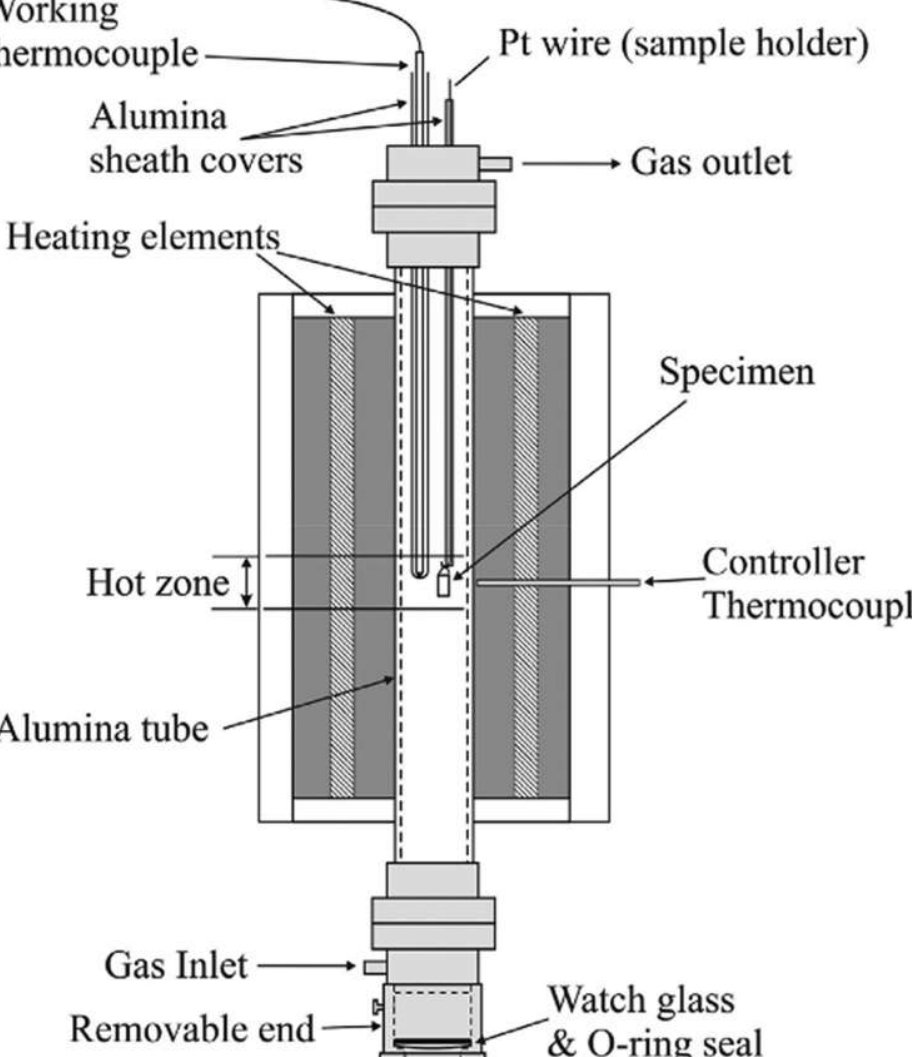
Figure 3. Schematic diagram of the vertical resistance furnace used in the water quenching ex- periment.